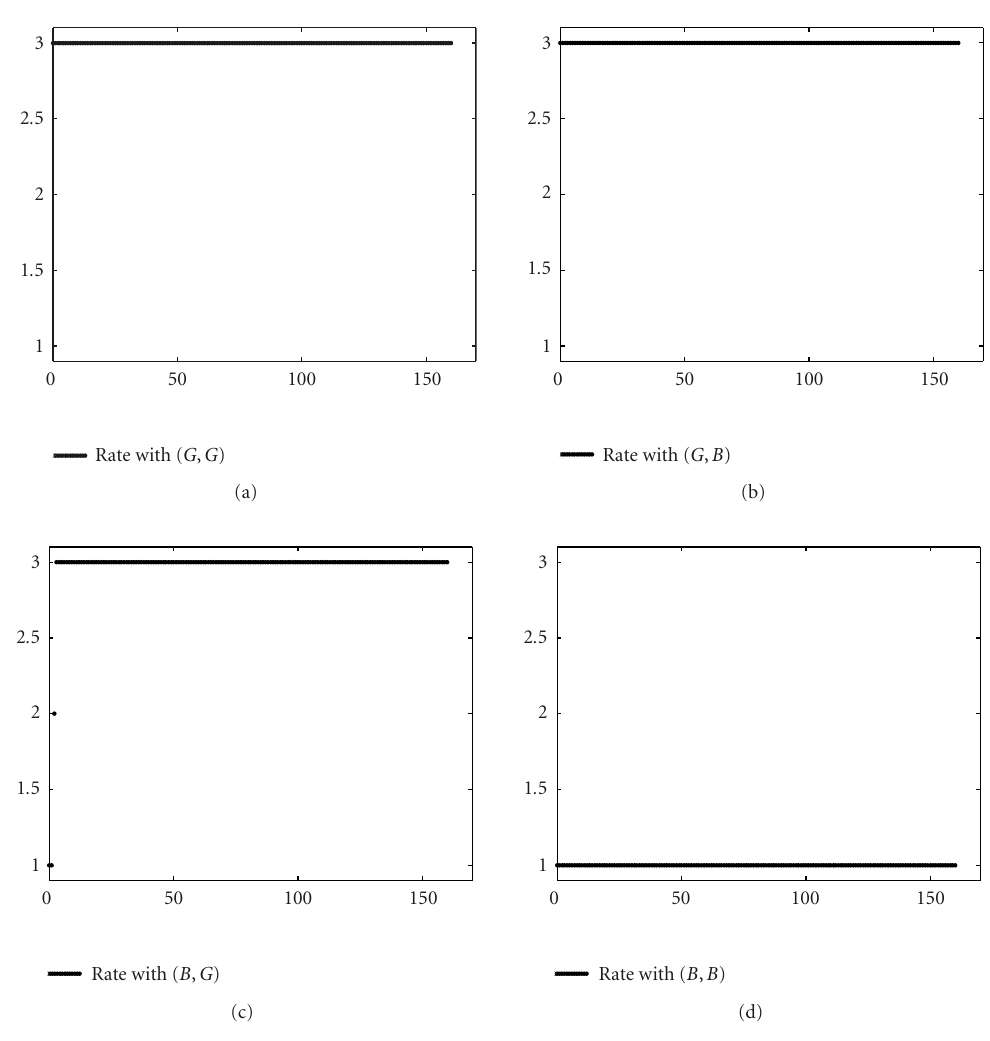
Figure 8: The optimal rate assigned to the active link for di ff erent combinations of channel states. Except the case of ( G , B ), there is a switch of transmitting node as shown in Figure 7. Horizontal axis: bu ff er level; vertical axis: